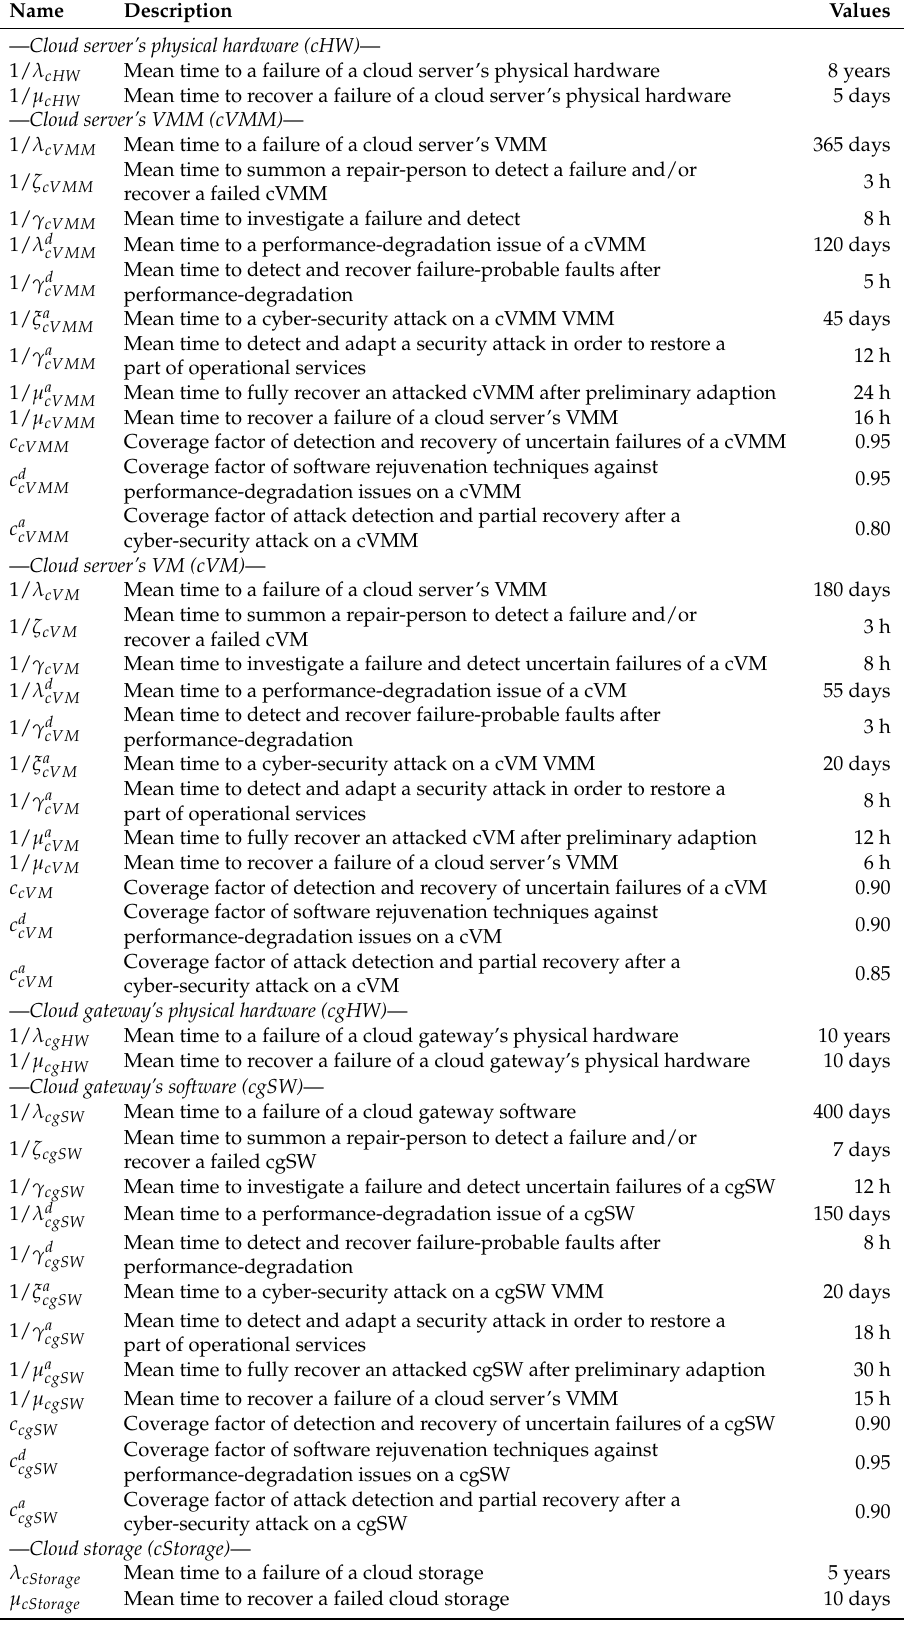
Table 1. Default input parameters for models of the cloud member